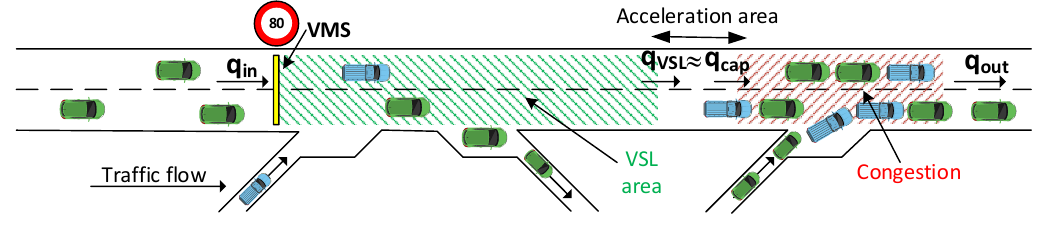
Figure 1. Application of Variable Speed Limit (VSL) for the bottleneck